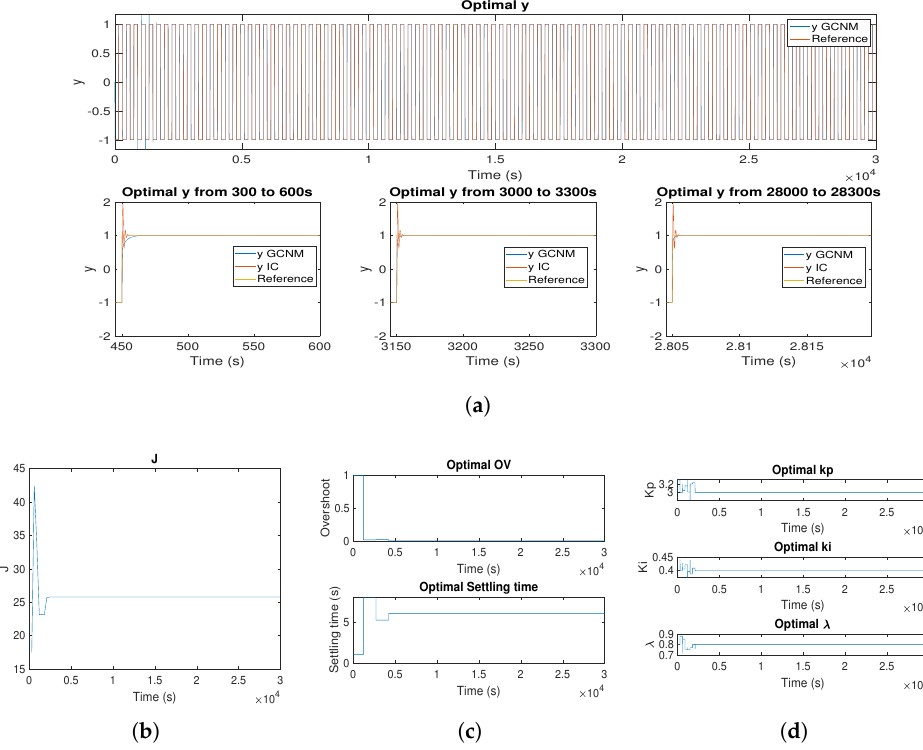
Figure 4. FOSOC controller: ( a ) time response, ( b ) cost function, ( c ) overshoot and settling time, and ( d ) FOPI gains evolution for L = 0.1